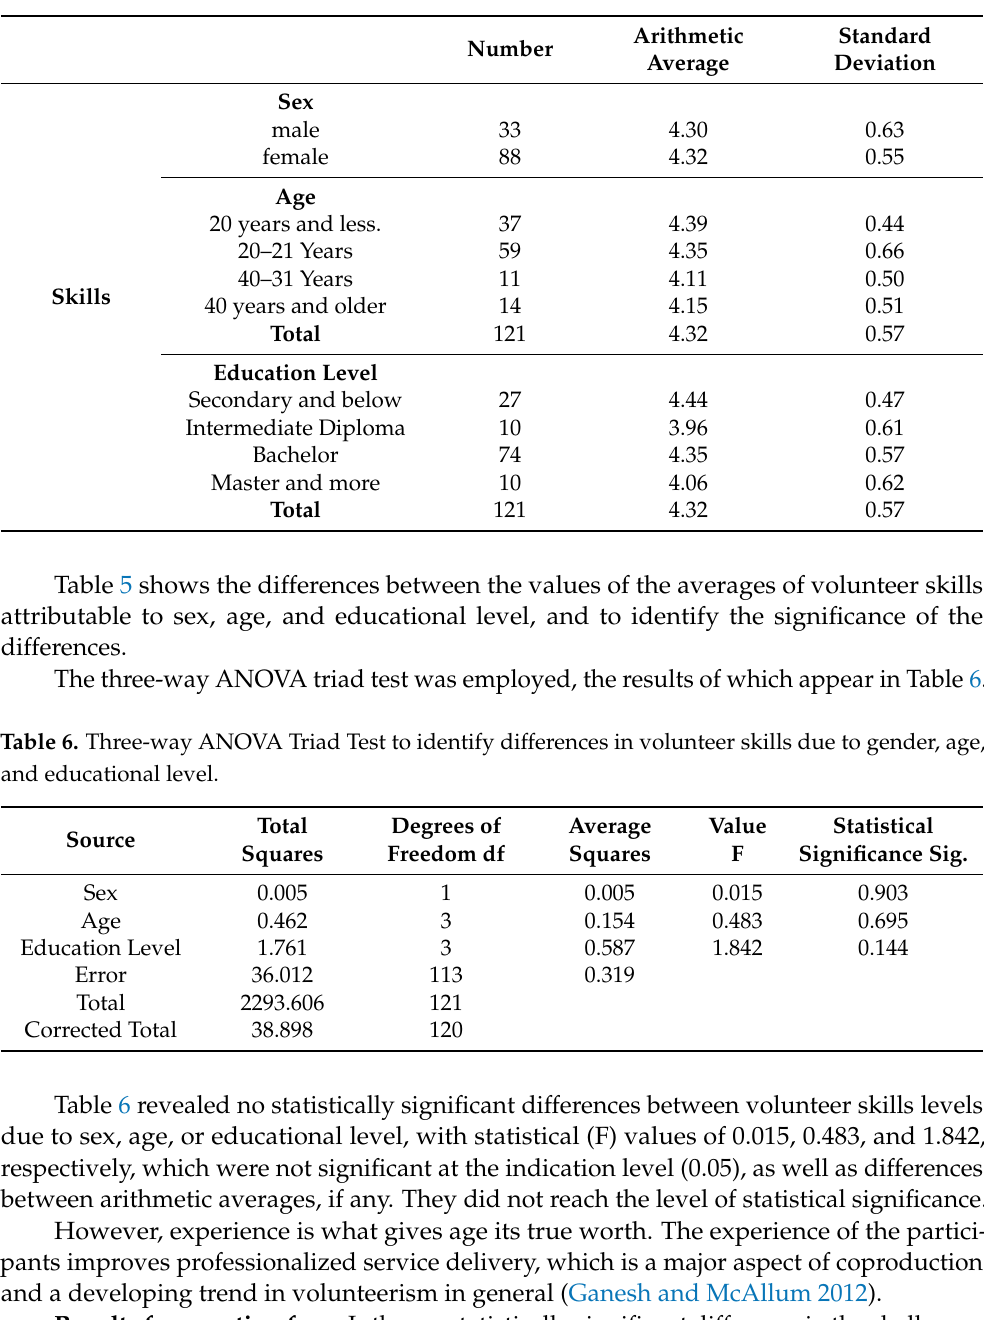
Table 5. Arithmetic averages and standard deviations to identify the level of volunteer skills at- tributable to sex, age, and educational level.